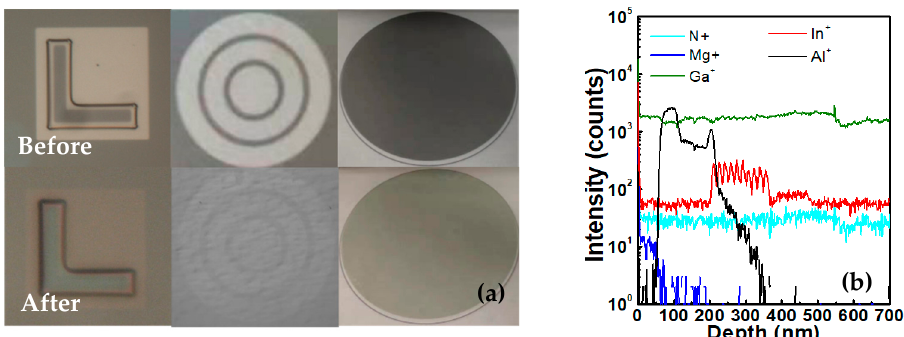
Figure 1. ( a ) Comparison between the samples before and after annealing. ( b ) Composition of the epitaxy measured by TOF-SIMs.